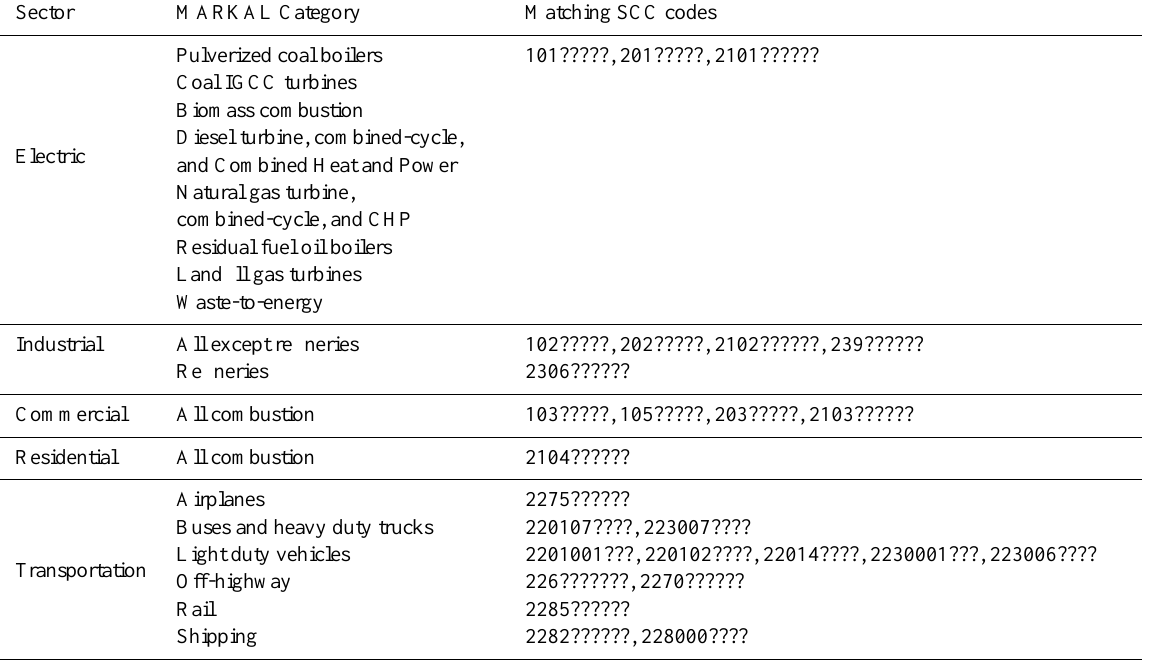
Table 1. Crosswalk linking MARKAL emission categories with matching SCC codes. Question marks represent